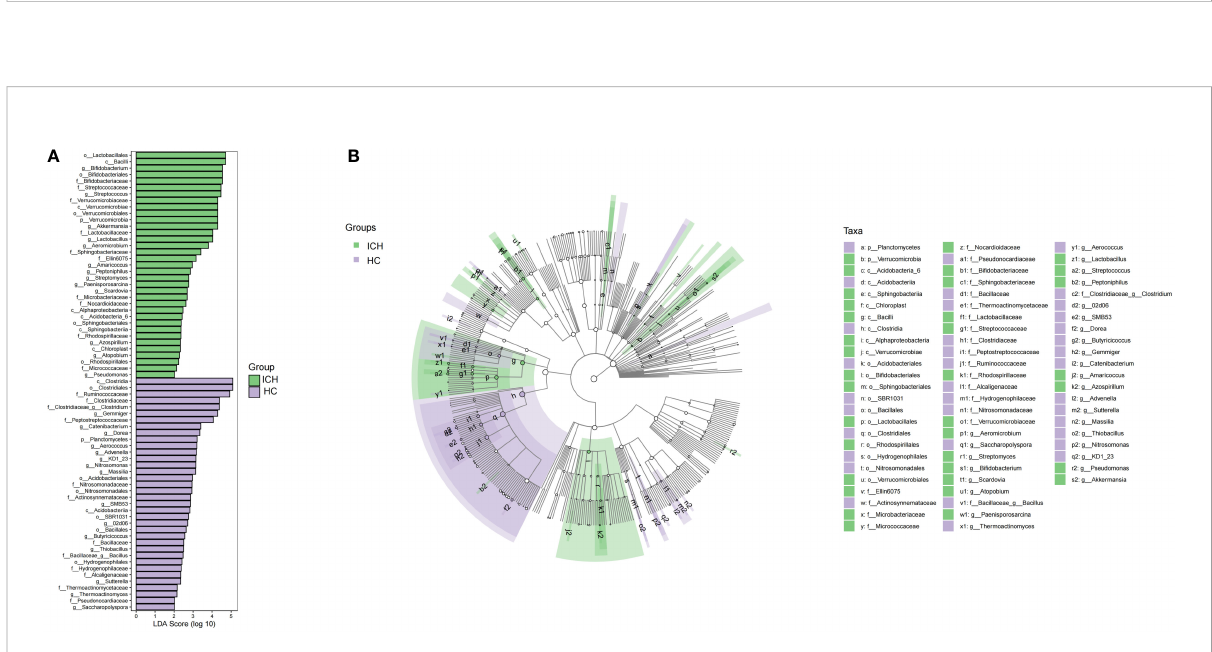
FIGURE 2 Varying and phylogenetic distribution of microbiota correlated with the ICH and HC groups. (A) Microbiota in signi fi cantly varying abundances (from phylum to genus level) between the ICH and HC groups; (B) Cladogram radiating from the inside to the outside representing the taxonomic level of microbiota from the phylum to the